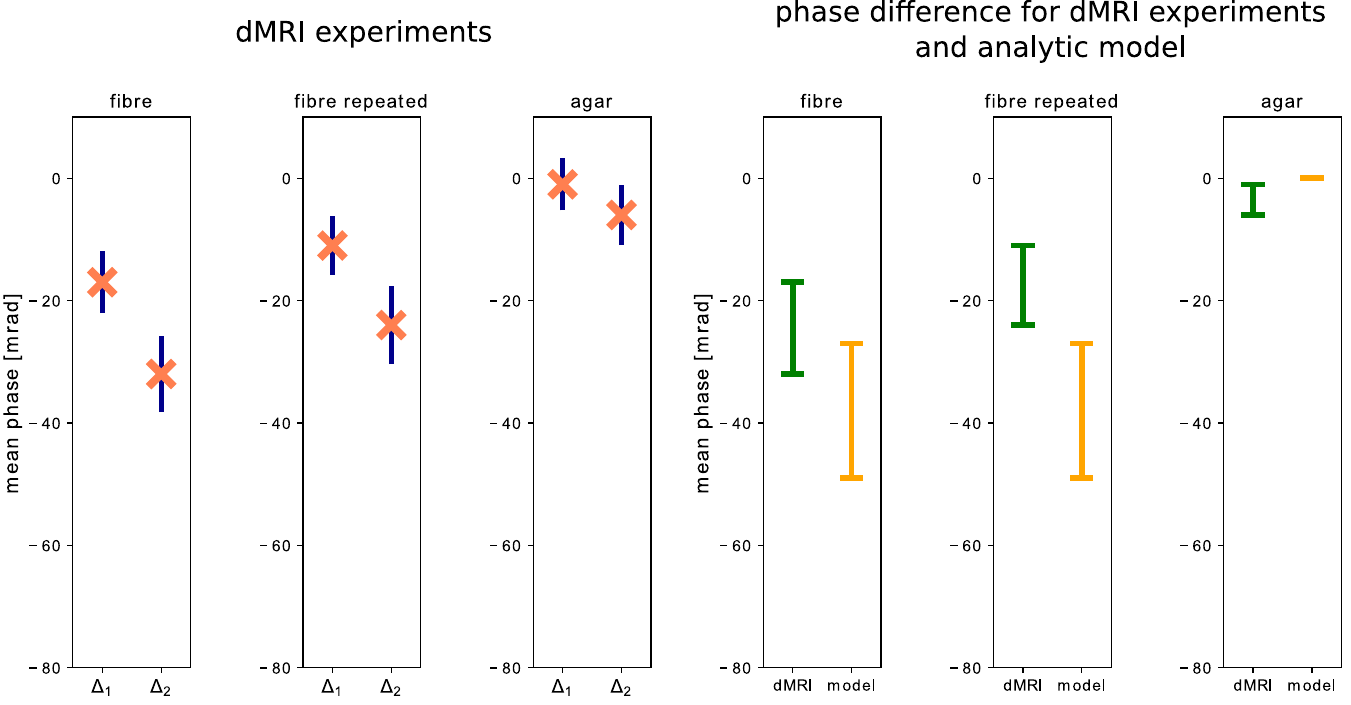
Fig 10. The results of the dMRI experiments: The three plots on the left show the mean phase over time for the pixel associated with the saddle point of the gradient field for Δ 1 and Δ 2 . The acquired baseline was used to correct for phase errors. The resulting error was determined using error propagation. The three plots on the right compare the difference of the measured mean phase (green) between Δ 1 and Δ 2 to the difference estimated by the analytic model (orange). The upper and the lower bar mark the phase for Δ 1 and Δ 2 respectively.